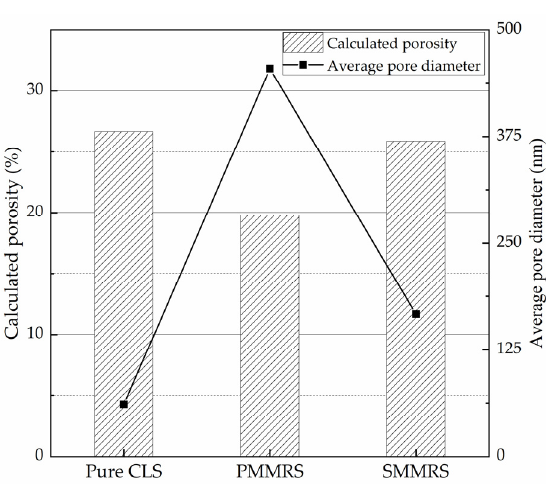
Figure 15. The calculated porosity and average pore diameter of PMMRS, SMMRS and pure CLS.